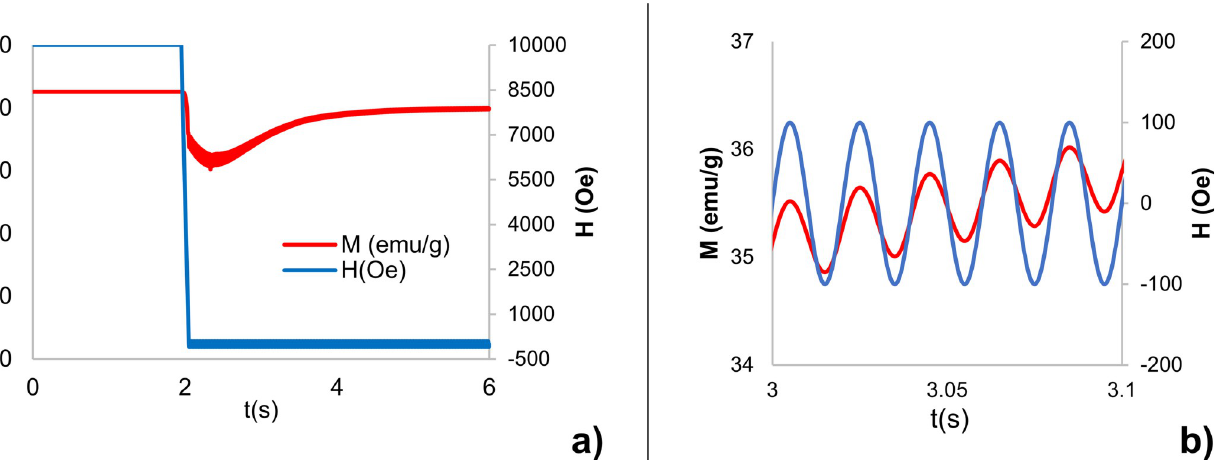
PLOS ONE | https://doi.org/10.1371/journal.pone.0274676 September 23,